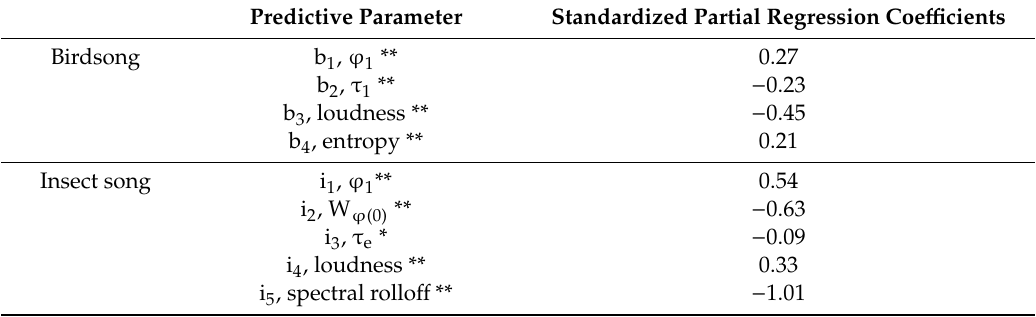
Table 4. Significant predictive parameters and standardized partial regression coe ffi cients in multiple linear regression analyses for birdsong and insect song. Asterisks indicate the level of significance, i.e., ** p < 0.01, * p <